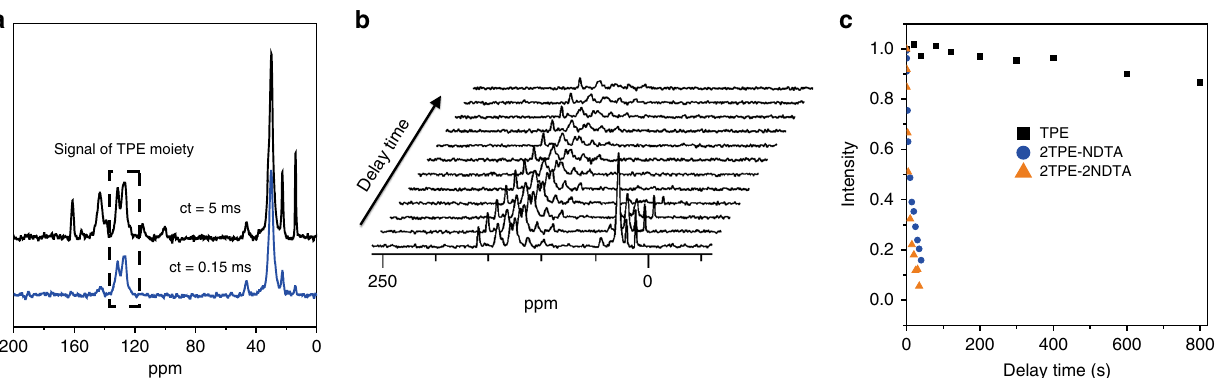
Fig. 3 The SSNMR of TPE, 2TPE-NDTA, and 2TPE-2NDTA. a 13 C CPMAS at 5 kHz with toss and varied contact time (CT) to assign the TPE peaks of 2TPE- NDTA. b 13 C relaxation measurements of 2TPE-NDTA with a relaxation time of about 5577s. c 13 C relaxation measurements of 2TPE-NDTA (red) and 2TPE-2NDTA (green) with relaxation times of 10.5 and 7.1 s,